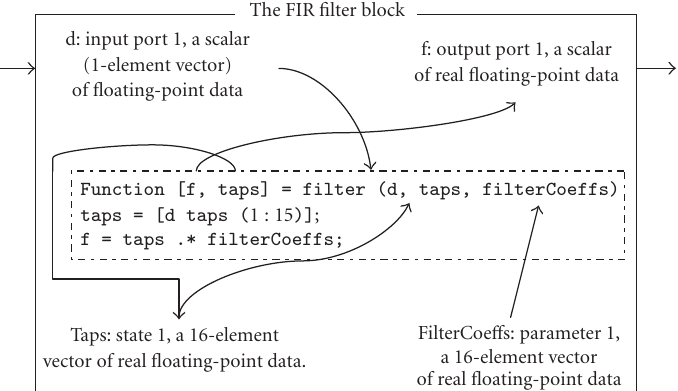
Figure 10: A Simulink block demonstrating the mapping of a Matlab function implementing a 16-tap FIR filter to the Simulink block. Arrows indicate the mapping from block elements to Matlab function parameters. A dotted line di ff erentiates the Matlab function from the Simulink block